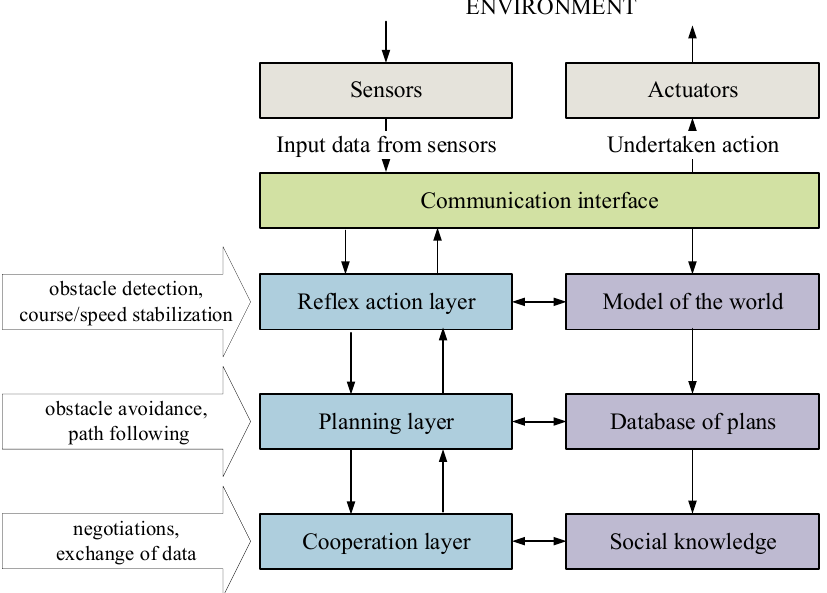
Figure 3. Agent architecture and control